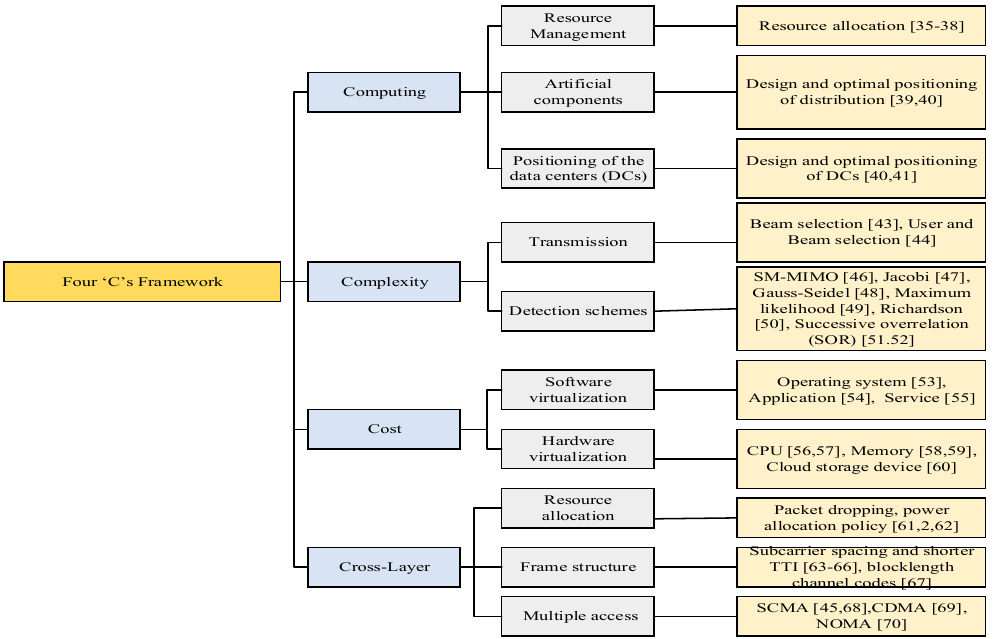
Figure 4. The classification of Four (4) C Model for Ultra-Low latency high capacity 5G communications.